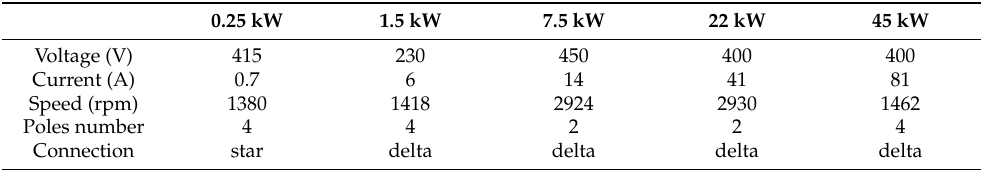
Table 1. Nominal values of the induction motors.